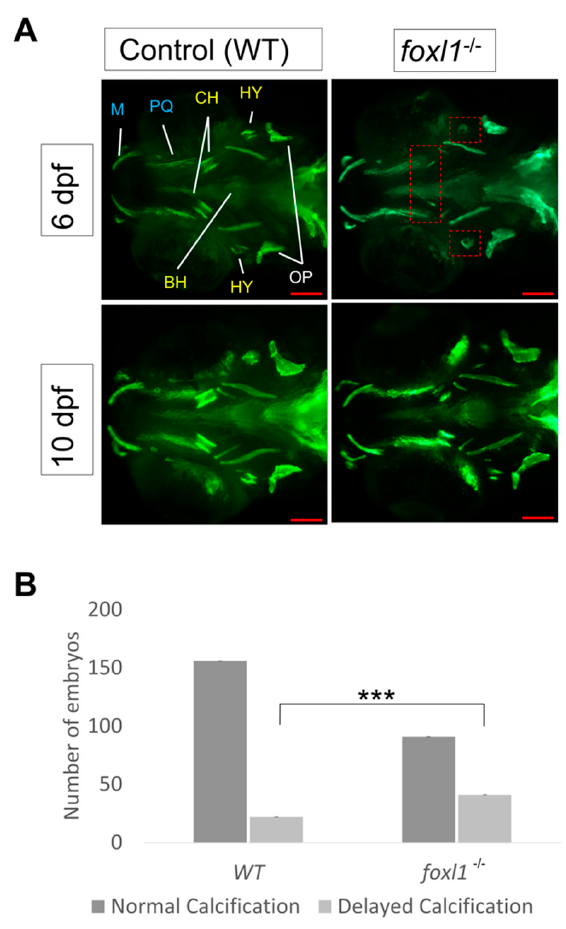
Figure 2. Calcein staining illustrating the impact of foxl1 loss on craniofacial development and calcification. ( A ) Embryos of WT aged 6 and 10 dpf ( n = 173 and 99, respectively) as well as those of foxl1 -/- ( n = 116 and 65, respectively). WT embryos at both 6 and 10 dpf exhibit normal craniofacial development and calcification of all jaw structures. foxl1 -/- embryos show a delayed calcification in the ceratohyal and hyomandibula (red boxes) at 6 dpf yet appear mostly recovered by 10 dpf. ( B ) The proportion of embryos with delayed calcification in foxl1 mutants is statistically significant (Fisher’s *** p = 0.0001) when compared to wildtype siblings. PQ, palatoquadrate; M, Meckel; HY, hyomandibula (hyosympletic); BH, basihyal; OP, opercula; CH, ceratohyal. Scale bars are 100 µm. 3.3. Overlapping Expression of foxl1, foxc1a, and foxc1b in